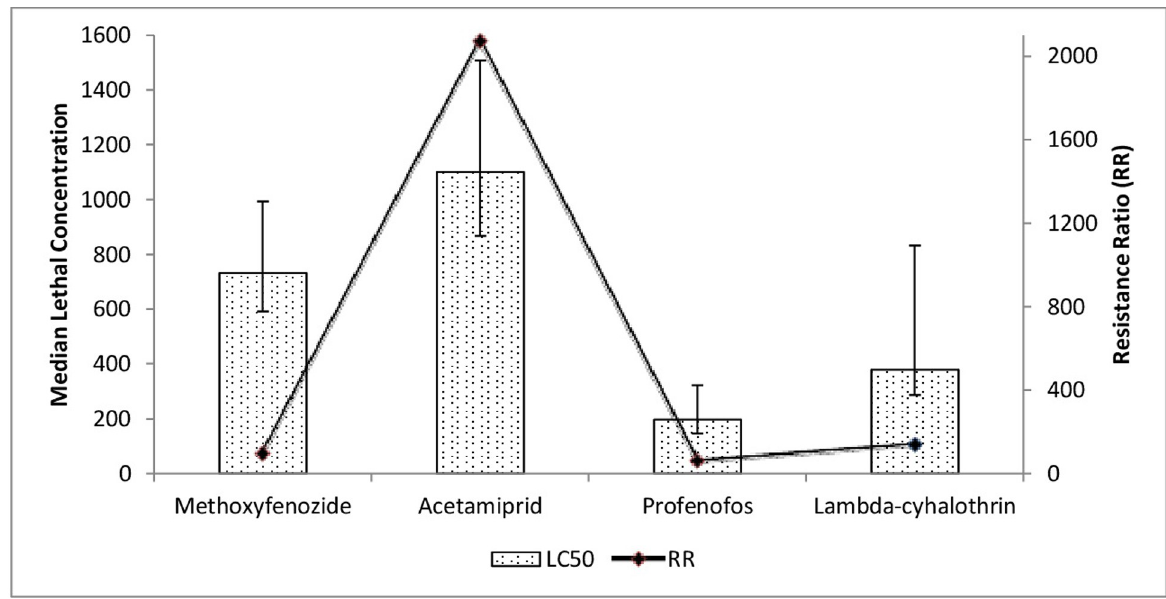
Fig 2. Toxicity of various insecticides to field strain (G1) of Chrysoperla carnea and resistance ratios. Error Bars show fiducial limits (FLs) of LC 50